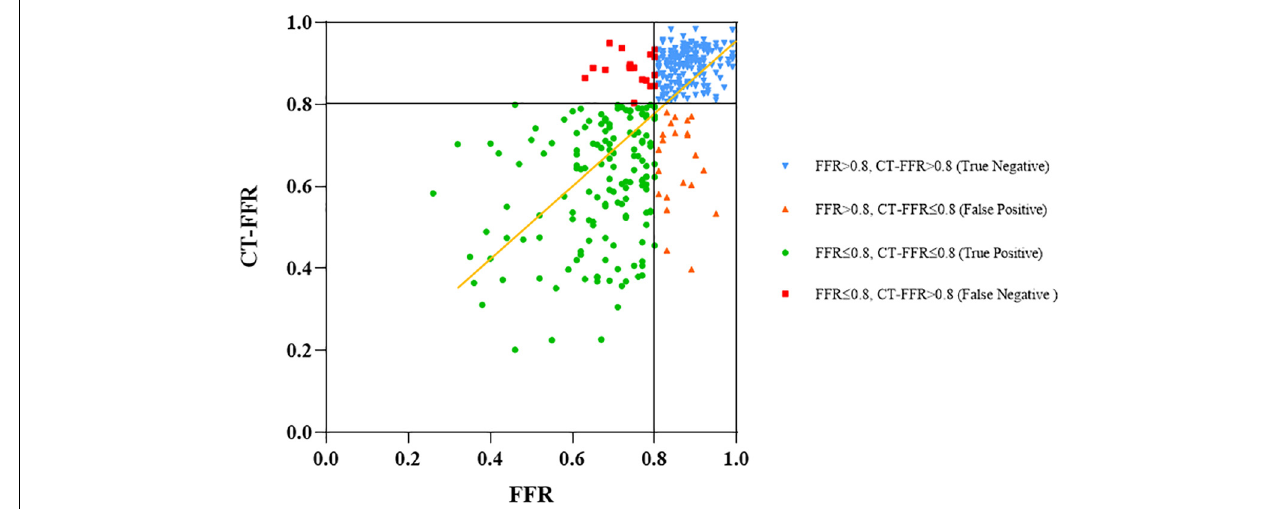
FIGURE 2 | Correlation between CT-FFR and invasive FFR. Measurements of CT-FFR and FFR are shown as a scatter plot (black lines show the 0.8 cutoffs and yellow line shows the fitted